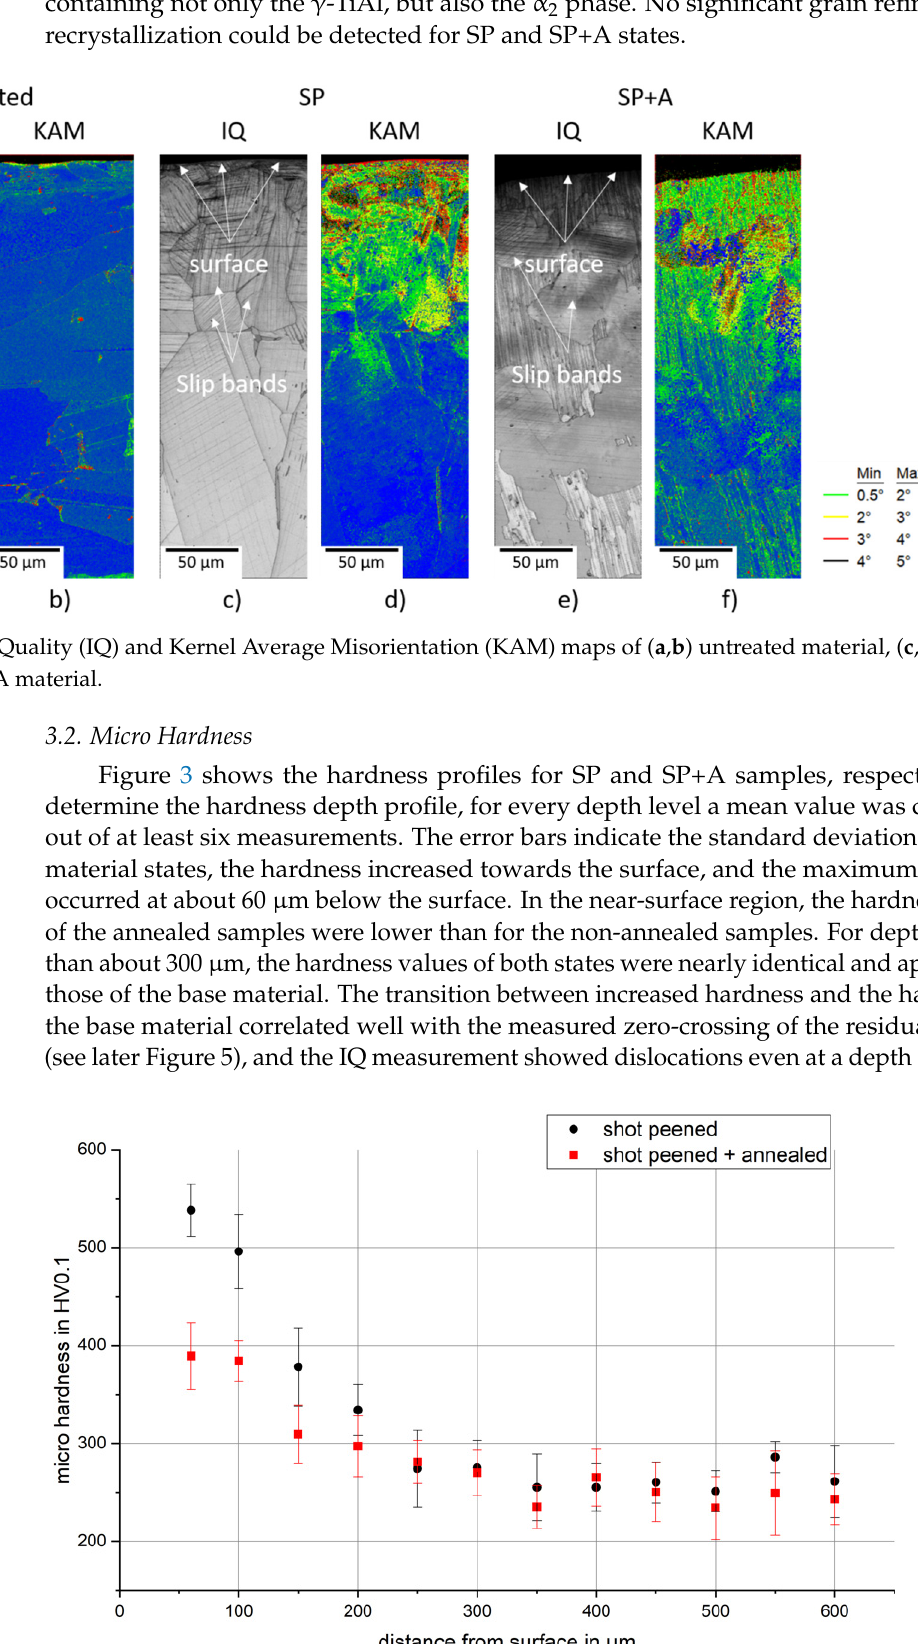
( b ) Figure 4. Result of X-ray stress analysis: ( a ) Residual stress depth distributions for the SP and the SP+A samples and ( b ) the corresponding depth distributions of the mean integral widths of the diffraction lines.